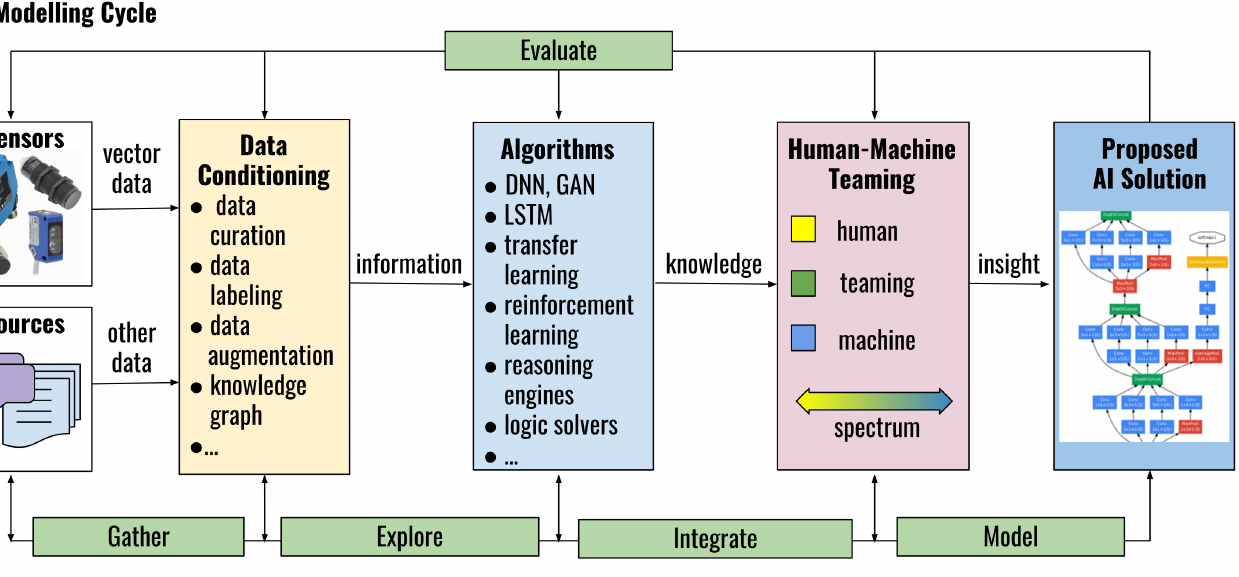
Figure 2. Steps of Developing AI